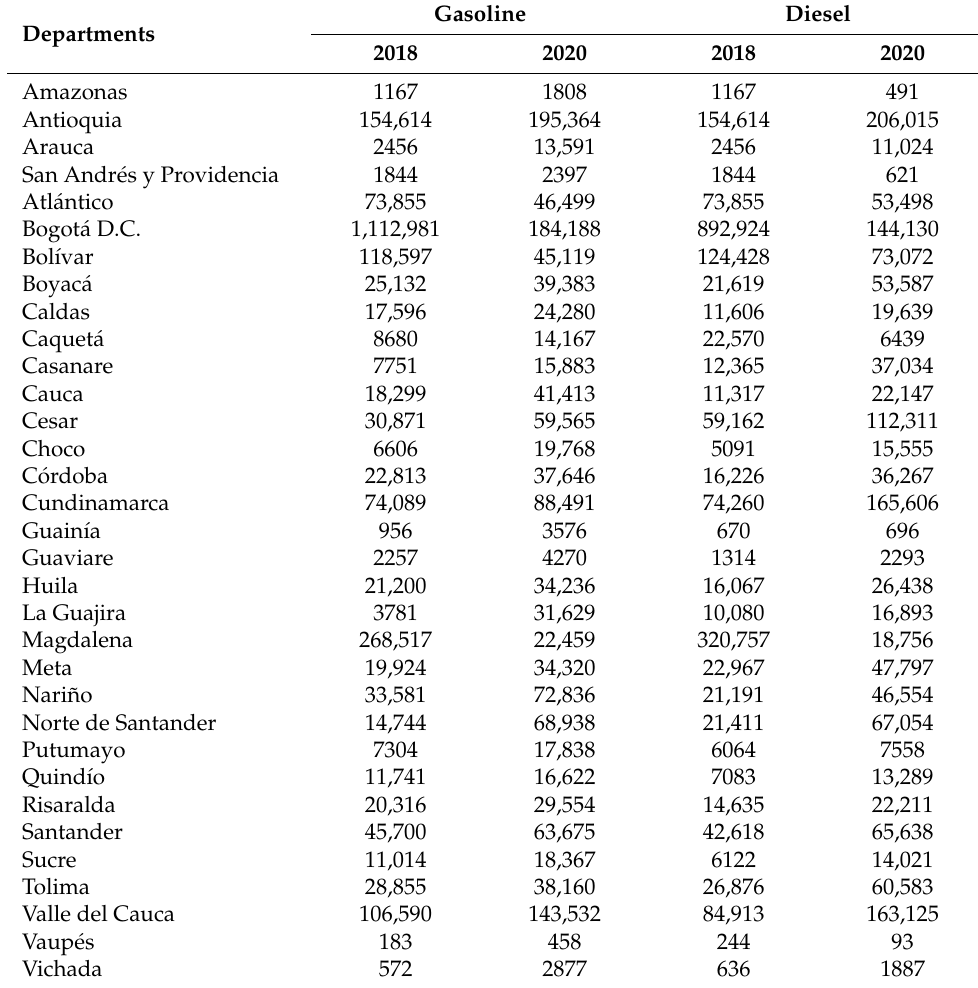
Table A2. Fuel sales (m 3 ) by department for March to June 2018 and